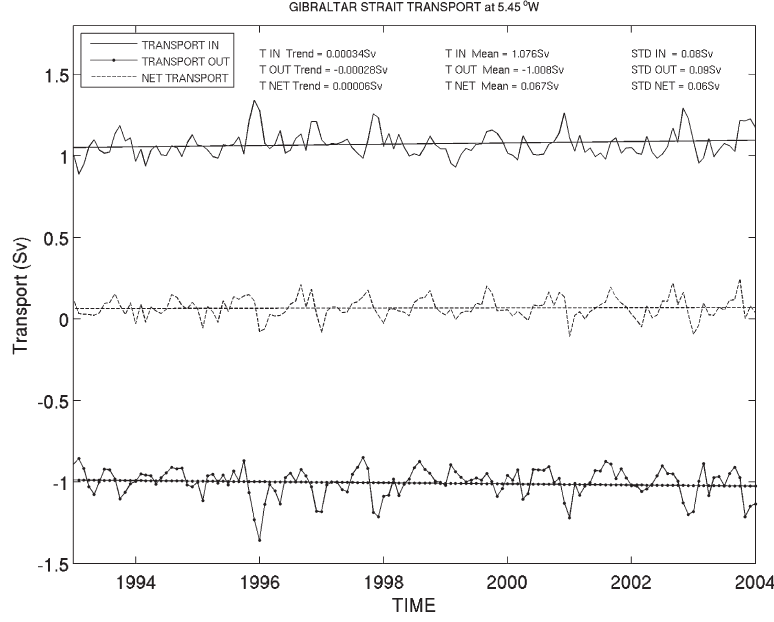
Fig . 10. – Transport through the Strait of